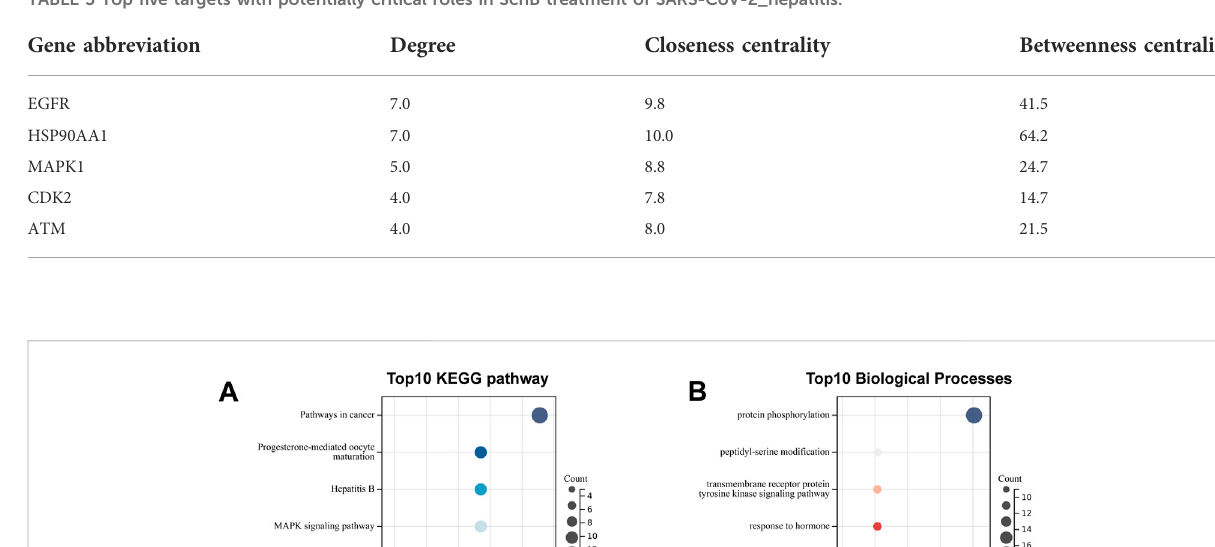
TABLE 3 Top fi ve targets with potentially critical roles in SchB treatment of SARS-CoV-2_hepatitis.